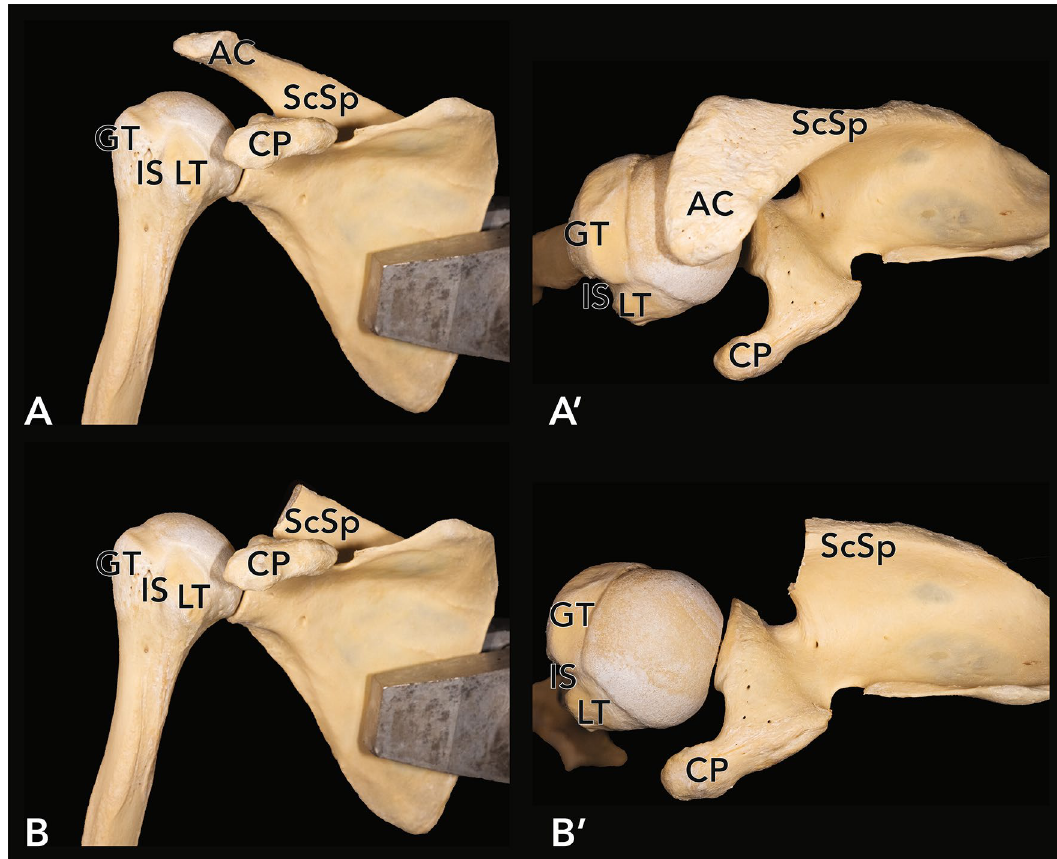
Figure 7. Exemplary view of the osseous morphology before ( A , A ′ ) and after ( B , B ′ ) removal of the acromion of the scapula in a right shoulder. View from anterior ( A , B ) and from superior ( A ′ , B ′ ). AC acromion,